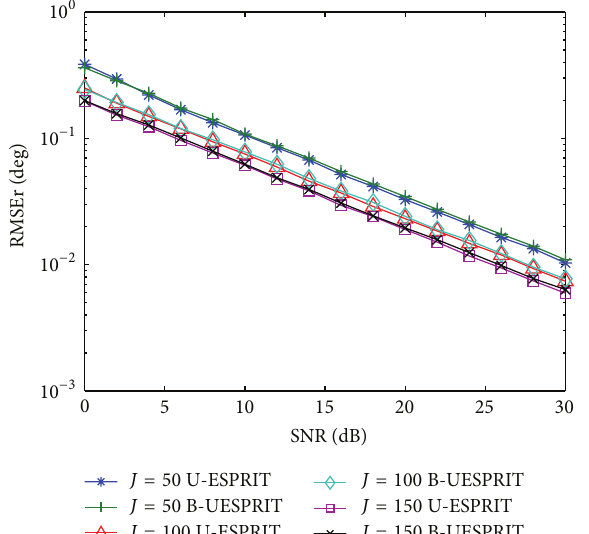
Figure 9: Probability of resolution versus angular separation 𝛿 , at SNR = 20 dB, 𝐽 = 50 .